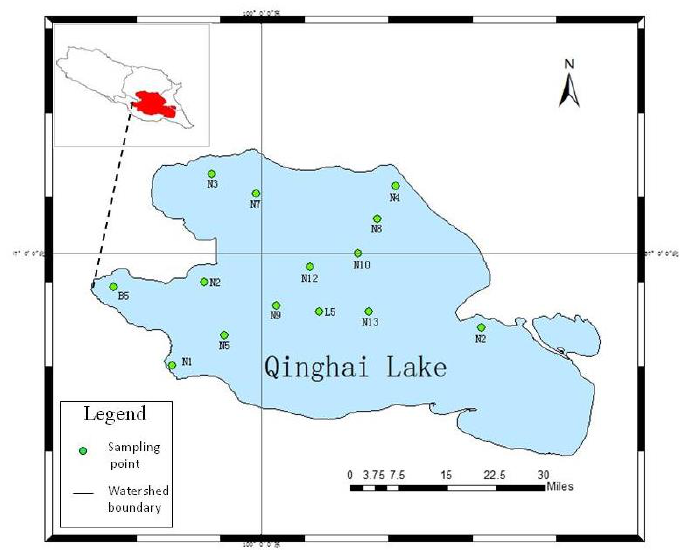
Figure 3. Locations of the DOM sampling points in Qinghai Lake.